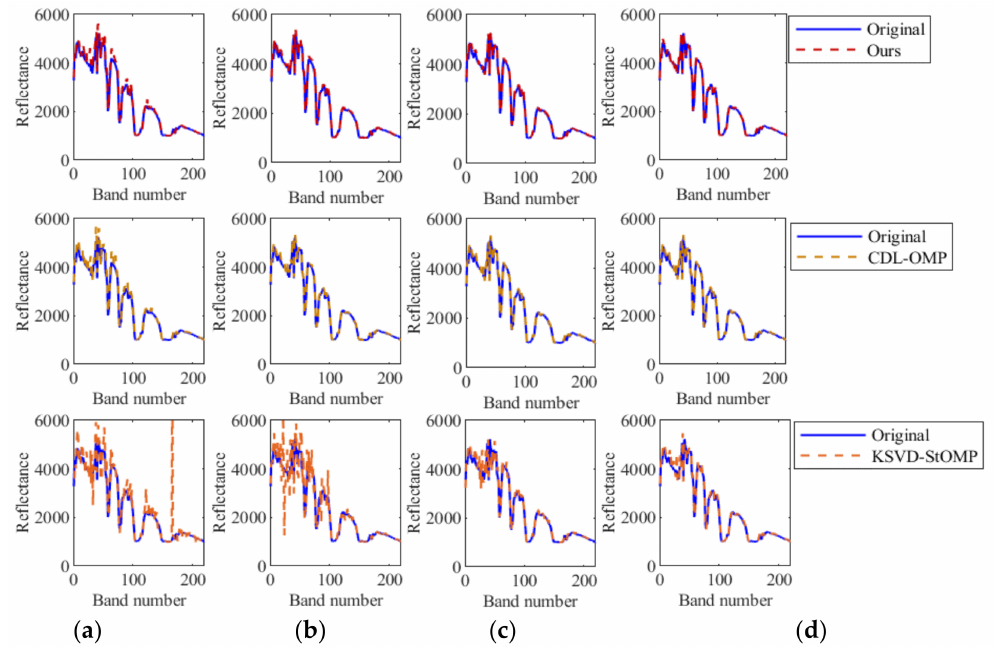
Figure 7. The original and reconstructed spectral lines of the pixel at coordinates (256, 1). From top to bottom, they are TIPML algorithm, CDL-OMP, and KSVD-StOMP. From the first column to the fourth column ( a ) The sampling rate SR = 0.1; ( b ) The sampling rate SR = 0.2;( c ) The sampling rate SR = 0.3;( d ) The sampling rate SR =